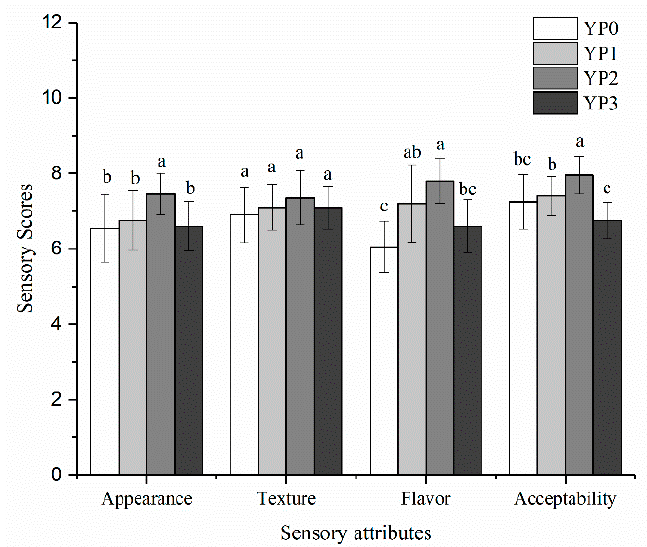
Figure 4. Scores of sensory indicators (D) for yak milk yogurts with different amounts of PEWH. Different letters indicate significantly different ( p <